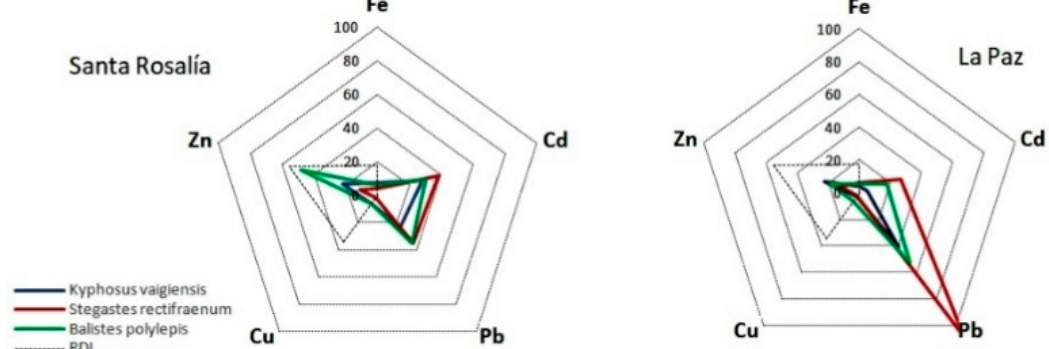
Figure 2. Estimated daily intake (EDI) of copper (Cu), zinc (Zn), iron (Fe), cadmium (Cd), and lead (Pb) in humans from the consumption of muscle of K. vaigiensis , S. rectifraenum and B. polylepis fish species in relation to the recommended daily dose (RDI) and how it last represents versus the reference dosis of each element.